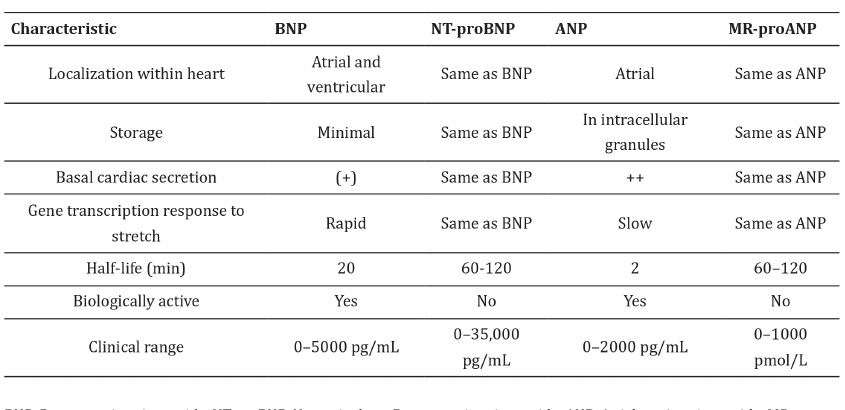
Figure 1. Summary of NPs’ characteristics [6]. The symbols “(+)” and “++” make a comparison between the secretion of each